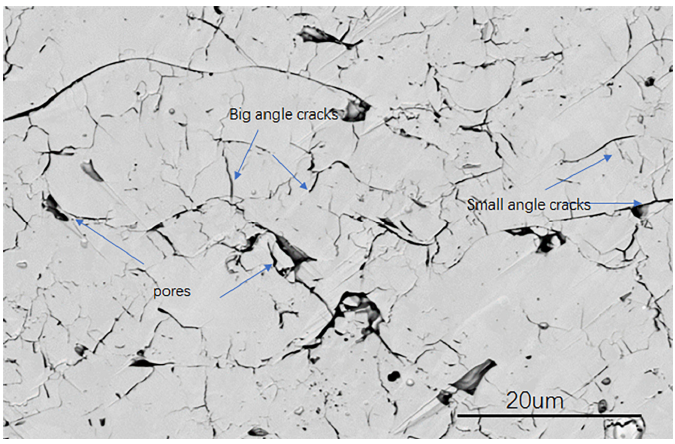
Figure 3. SEM image of polished cross ‐ sections of APS N6 coating.